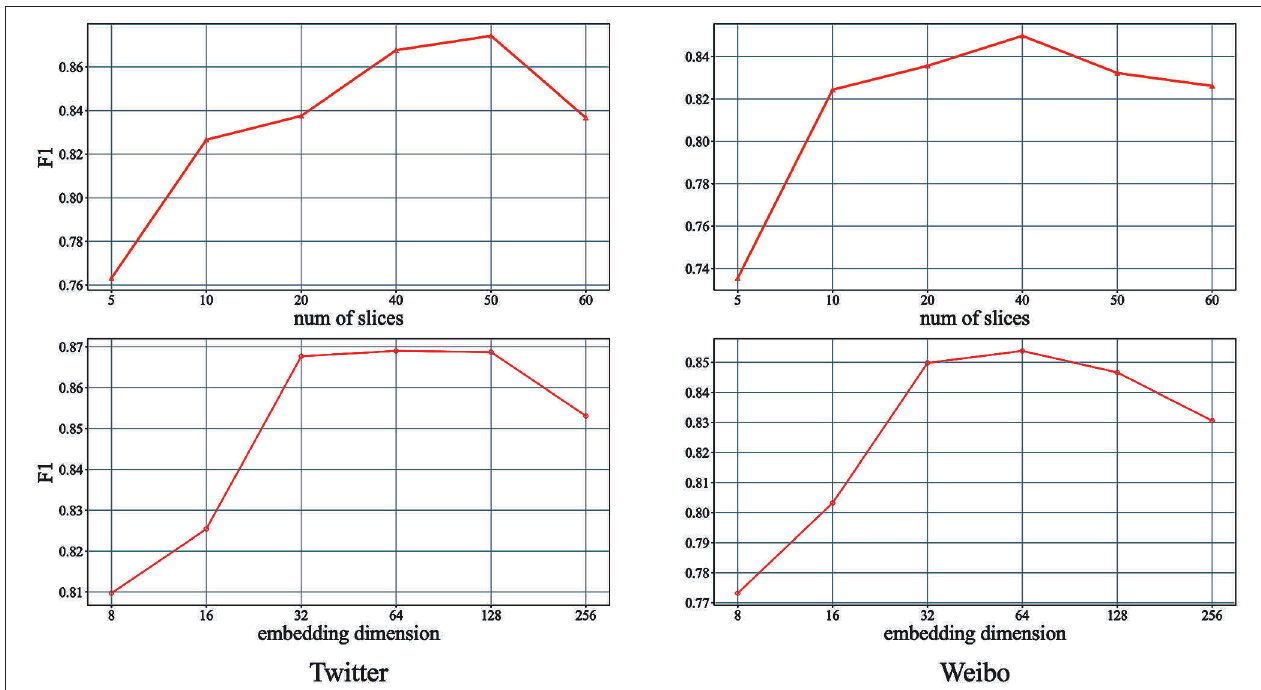
FIGURE 4 | Impact of different hyper-parameters on prediction